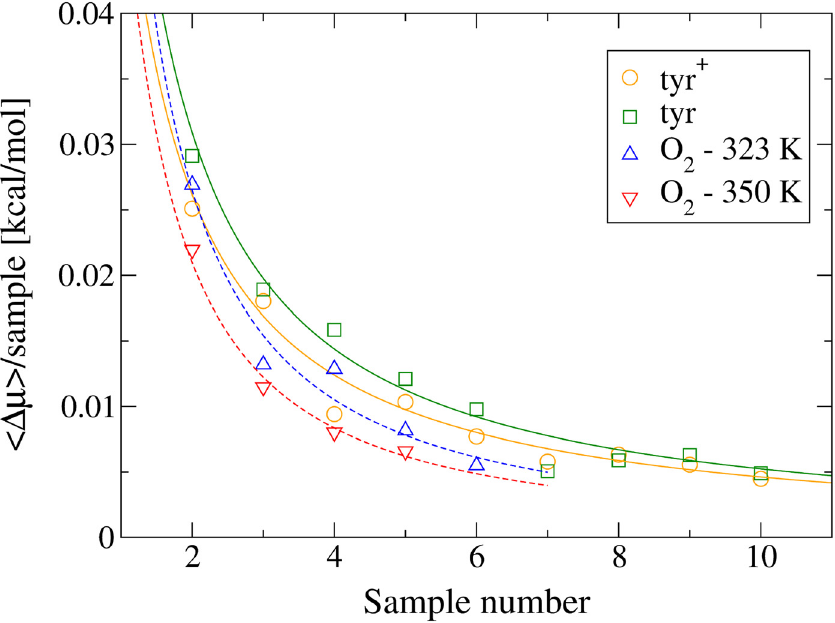
Fig 10. The average change in the mean, h Δ μ bin i , as samples are added to the Bayesian hypothesis about the mean. For example, at N = 2, h Δ μ bin i = h μ bin (2) − μ bin (1) i , and the most probable value from each Bayesian distribution was used for μ bin . The set averaged over was comprised of one bin every 1 Å (i.e. only every fifth bin was used). The fitted curve for tyr + was calculated without the outlier at Sample 4, while the curve for tyr was fitted without Sample